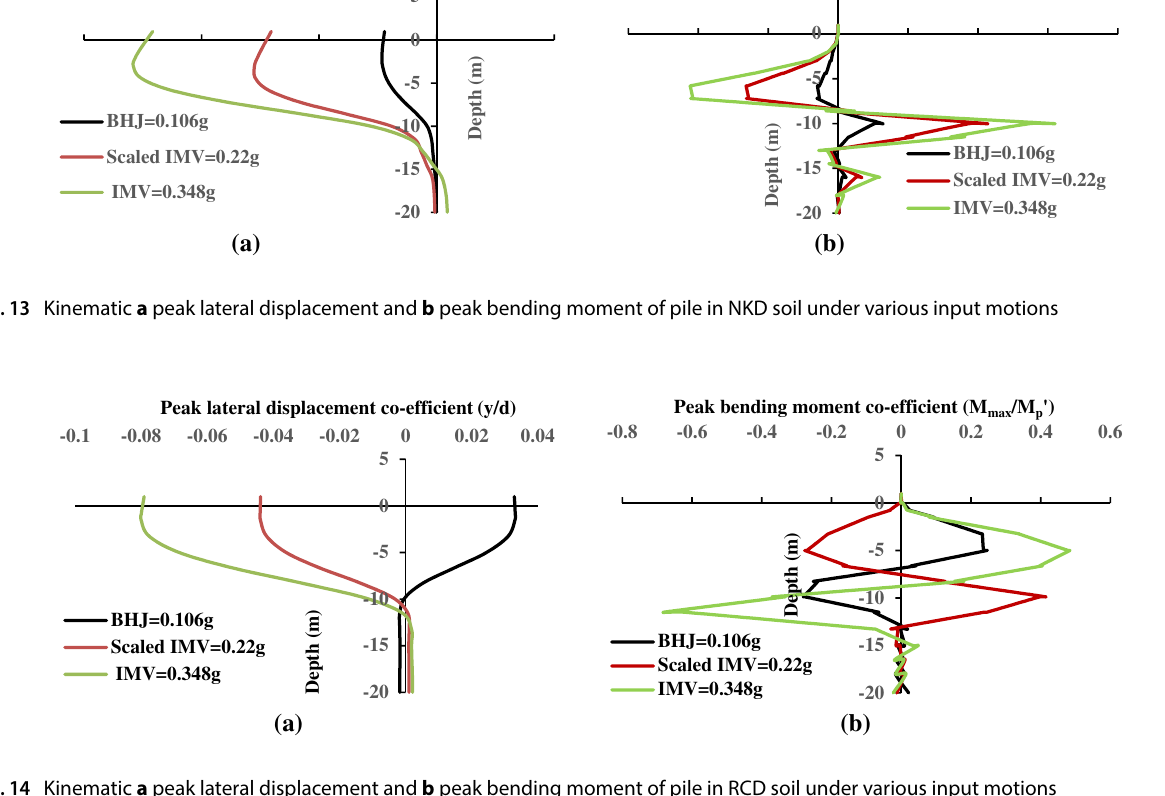
Fig. 14 Kinematic a peak lateral displacement and b peak bending moment of pile in RCD soil under various input